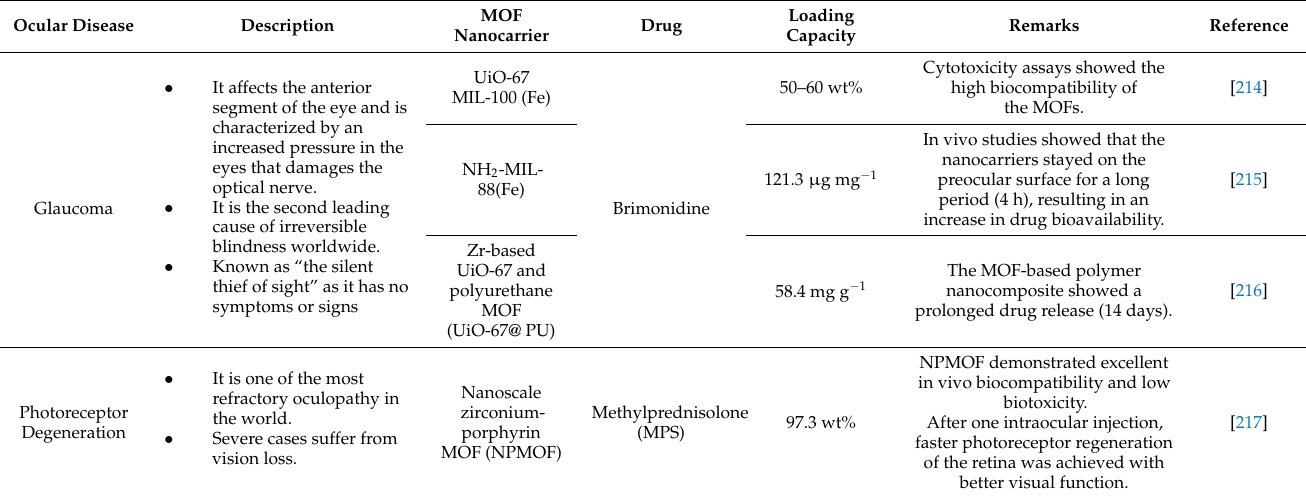
Table 6. Ocular diseases with their MOF-based